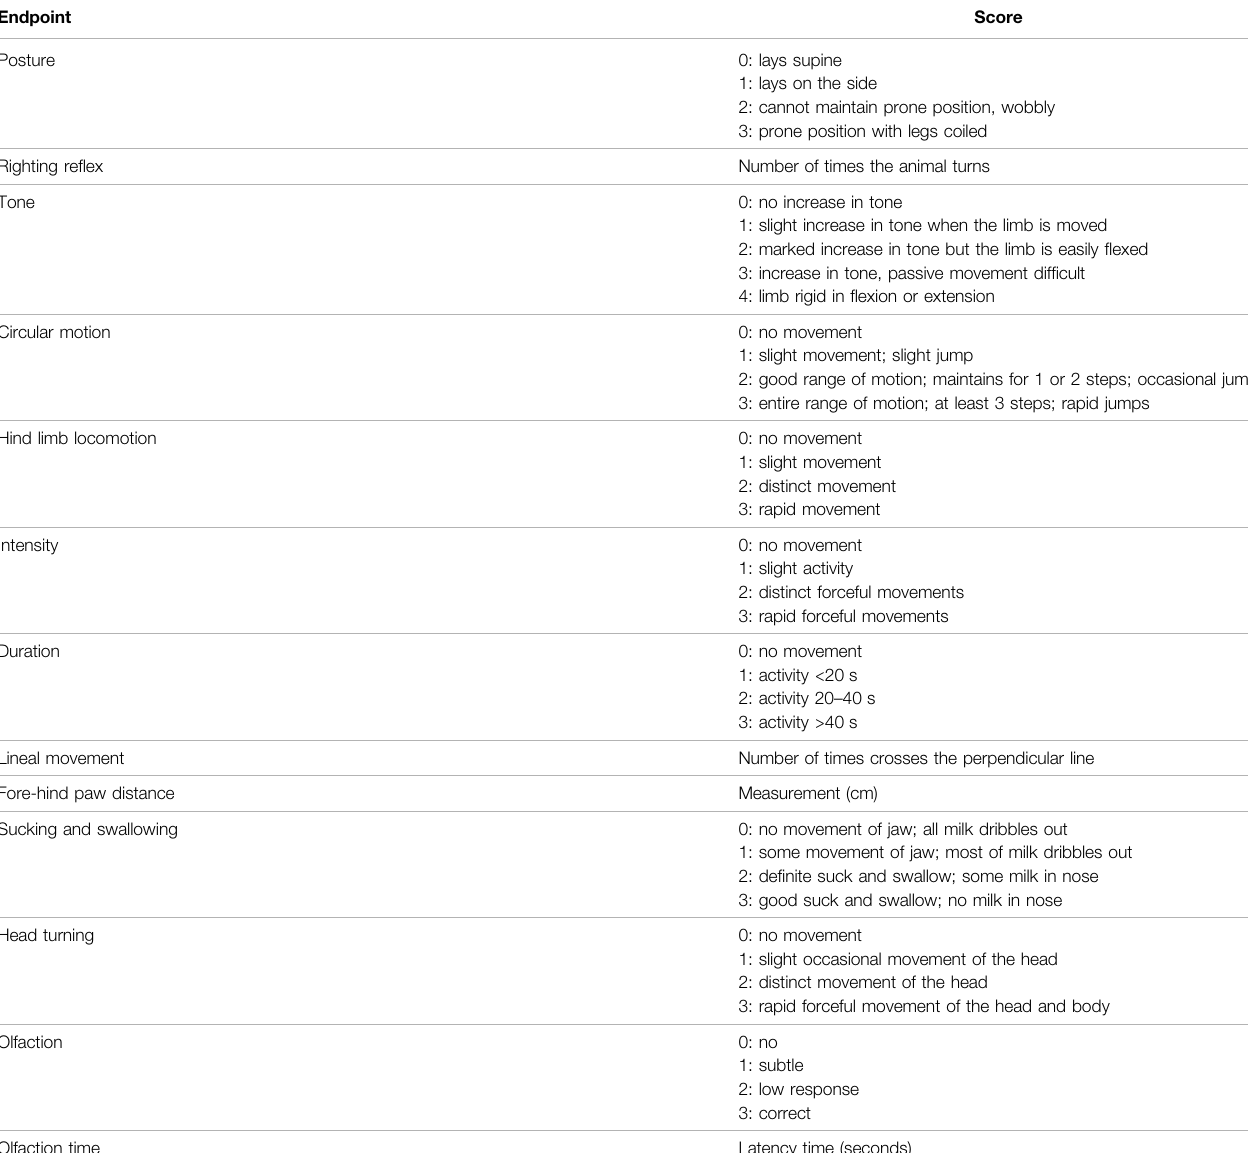
TABLE 1 | Scoring system for behavioral ontogeny